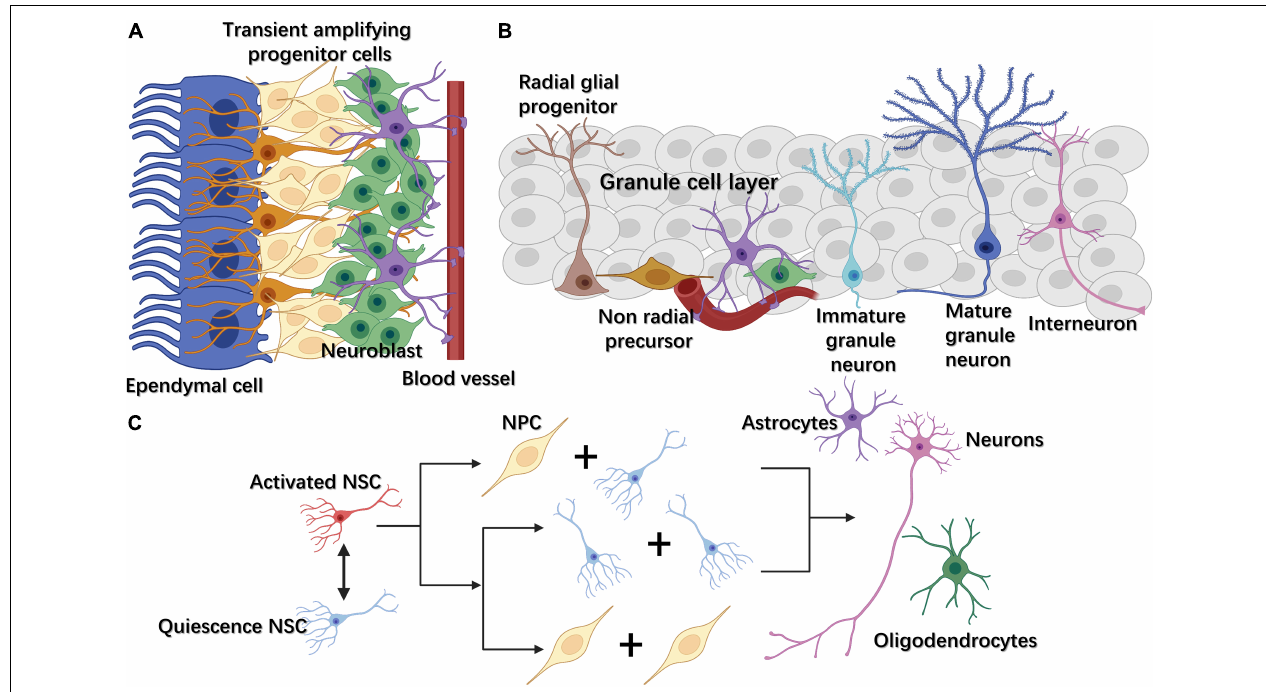
FIGURE 1 | (A) In the subventricular zone (SVZ), NSCs, also called radial glia-like cells, gradually differentiate into transient amplifying progenitor cells and neuroblasts. (B) In the subgranular zone (SGZ), radial glia-like cells differentiate into non-radial progenitor cells, intermediate progenitor cells (IPCs), and neuroblasts. The latter become mature excitatory granule neurons, which gradually migrate to the granule cell layer and extend their dendrites toward the molecular layer in the hippocampus. (C) Adult neural stem cells (NSCs) can exit or enter the cell cycle through changing between quiescence and activated states. Once activated, NSCs can divide either symmetrically or asymmetrically. Neural progenitor cells (NPCs) can further differentiate into three cell types: neurons, astrocytes, and